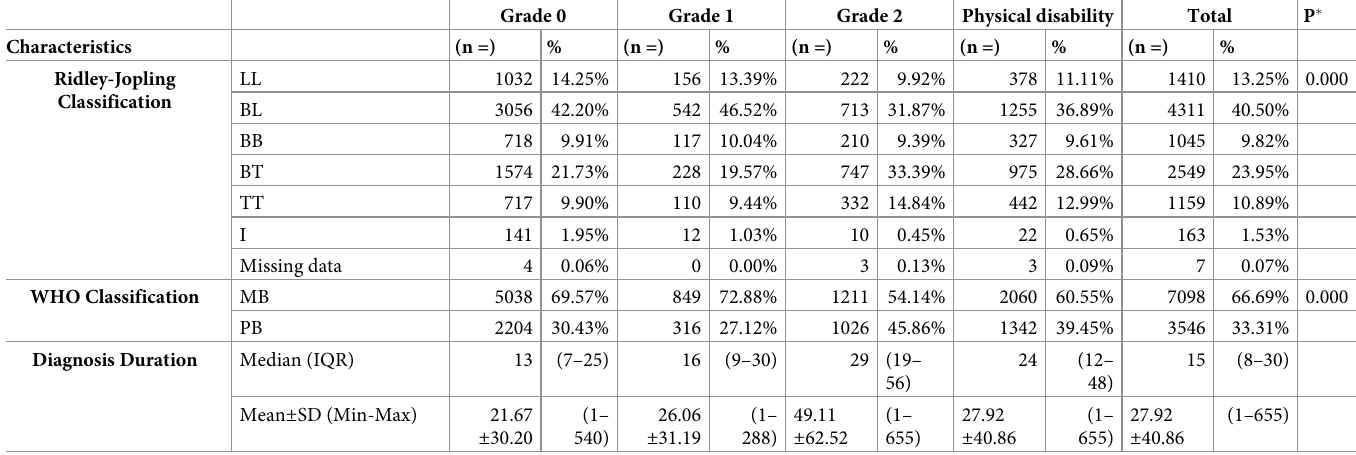
(I) forms of leprosy (Table 1). The median diagnosis durations were 13, 16, and 29 months for leprosy patients with G0D, G1D, and G2D, respectively. Risk factors for leprosy disease with G1D Table 2 summarizes all of the multinomial logistic regression results of risk factors associated with physical impairments graded as G1D and G2D separately when compared with G0D. Han ethnicity, rural occupation, nerve damage, delayed diagnosis, leprosy reaction, zero skin lesions, and Ridley-Jopling classification were associated with a higher risk of G1D. Regarding ethnicity, Han ethnicity increased the risk of G1D compared with minority ethnic- ities (OR: 1.424; 95% CI: 1.249–1.624; P = 0.000). Regarding occupation, working in rural